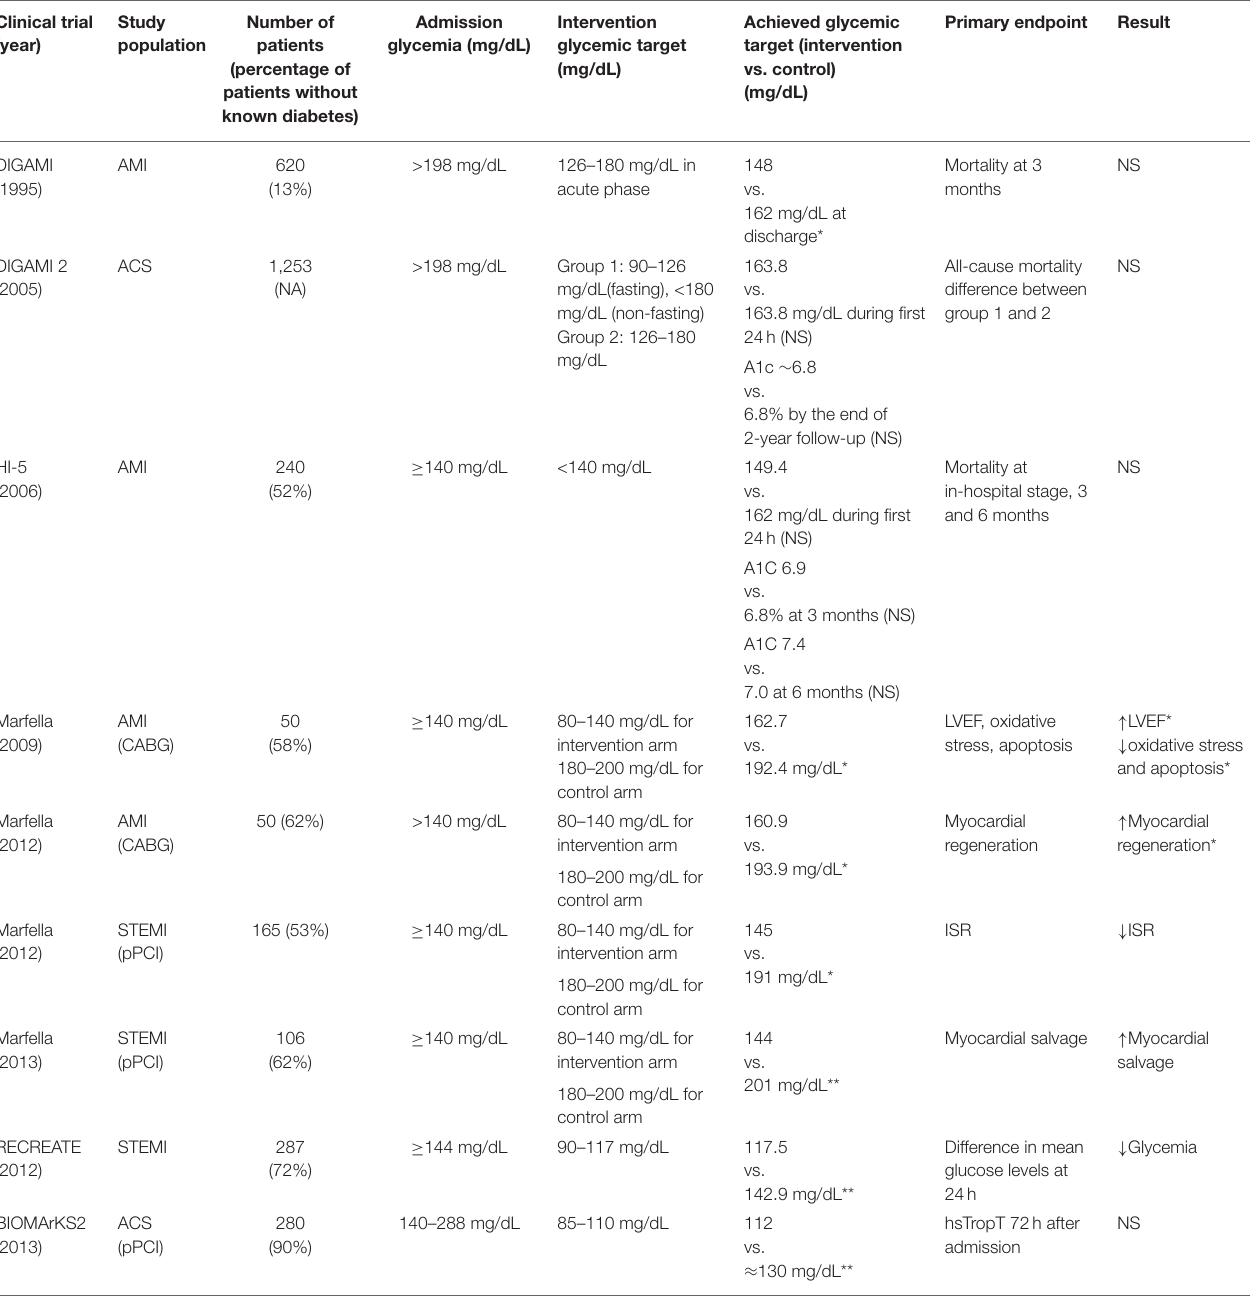
TABLE 1 | Randomized trials designed to compare effect of intensive glycemic control with that of standard therapy in patients presenting with ACS and associated SIH. Clinical trial